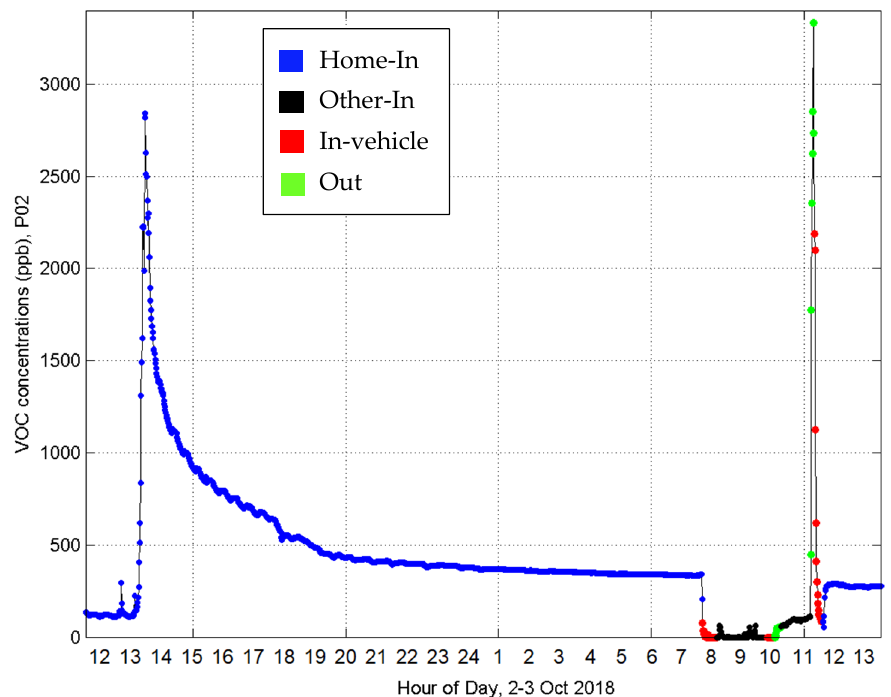
Figure 1. Example of time-course TVOC concentrations across 24 h for participant P02 in four different MEs.